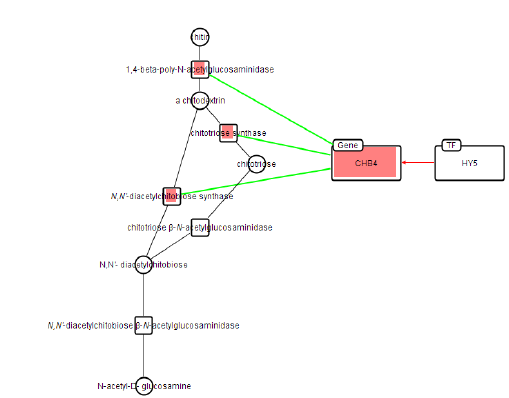
Figure 6: An extracted view, created using a user selection of an enzyme in the network with its corresponding re- action shown in Fig. 5.